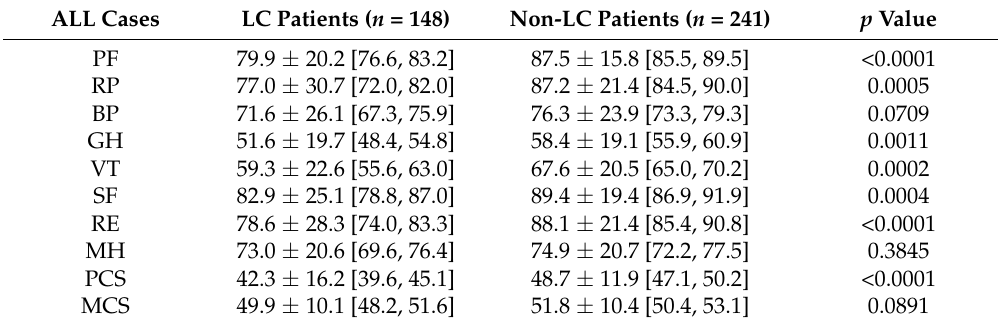
Table 2. Comparison of the SF-36 scores across 10 items in patients with LC and non-LC. ALL